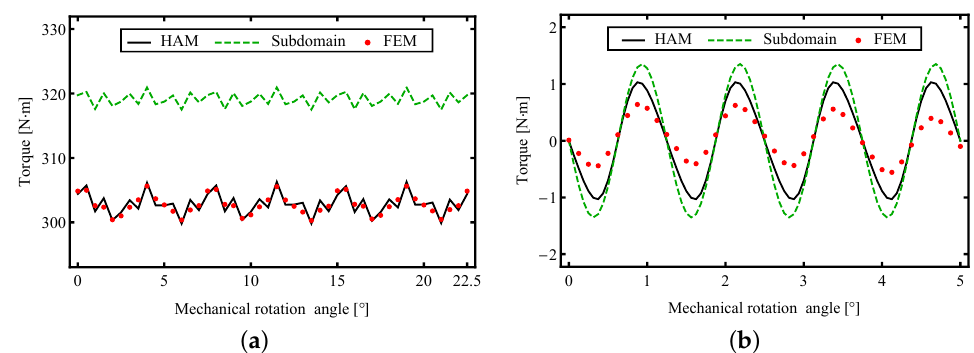
Figure 21. Comparison of torque pulsation of Machine I: ( a ) torque ripple with a current of 4 A (maximal amplitude); ( b ) cogging torque.